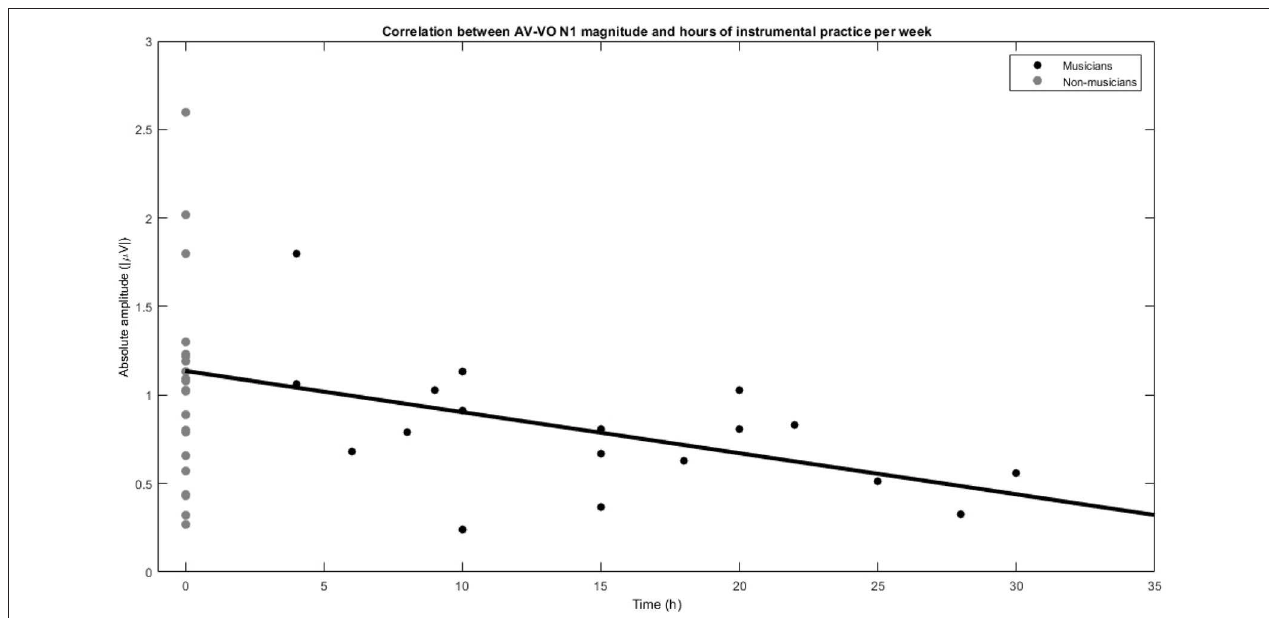
FIGURE 3 | Correlation between N1 magnitude in AV − VO and hours of instrumental practice per week for musicians and non-musicians.